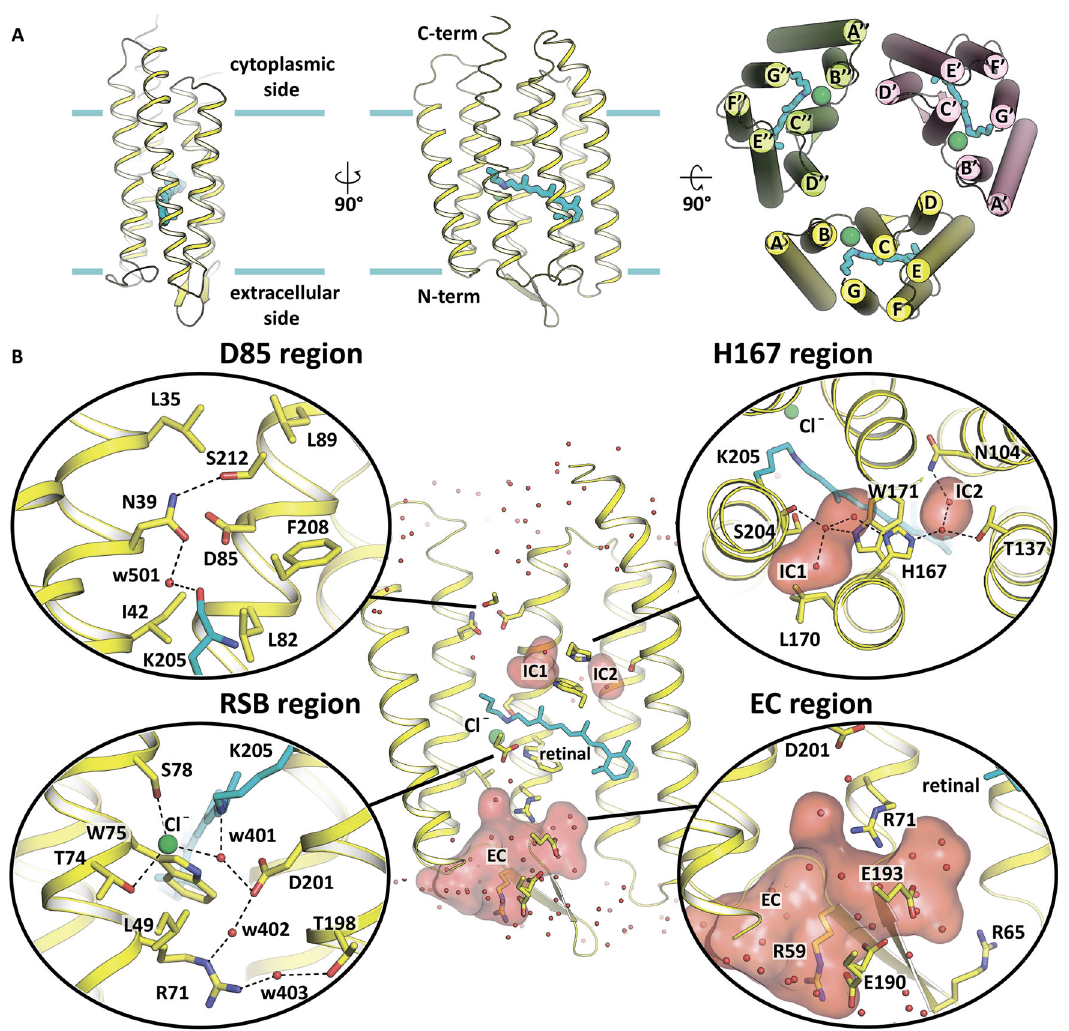
Fig. 2 | Structure of Sy HR protomer. A Overall view of the Sy HR protomer in the membrane. Calculatedhydrophobic-hydrophilic membrane boundaries are shown as blue lines. Chloride ion is shown as a green sphere. The right section shows the viewofthe Sy HRtrimerfromthecytoplasmicside. B Detailedviewofthe Sy HRkey